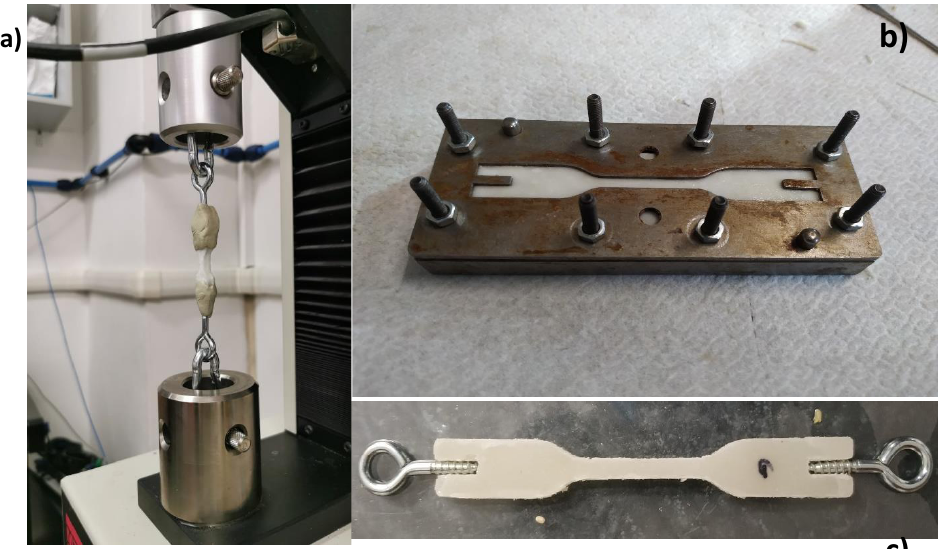
Figure 6. ( a ) Tensile test set-up; ( b ) baseplate and plates stacked during samples preparation; ( c ) multi- layer sample with